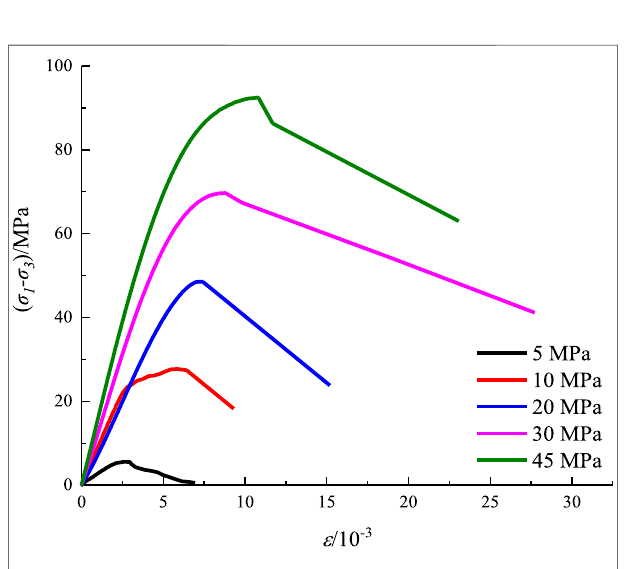
FIGURE 3 | Energy spectrum analysis and mineral element content of sandstone in gas storage.